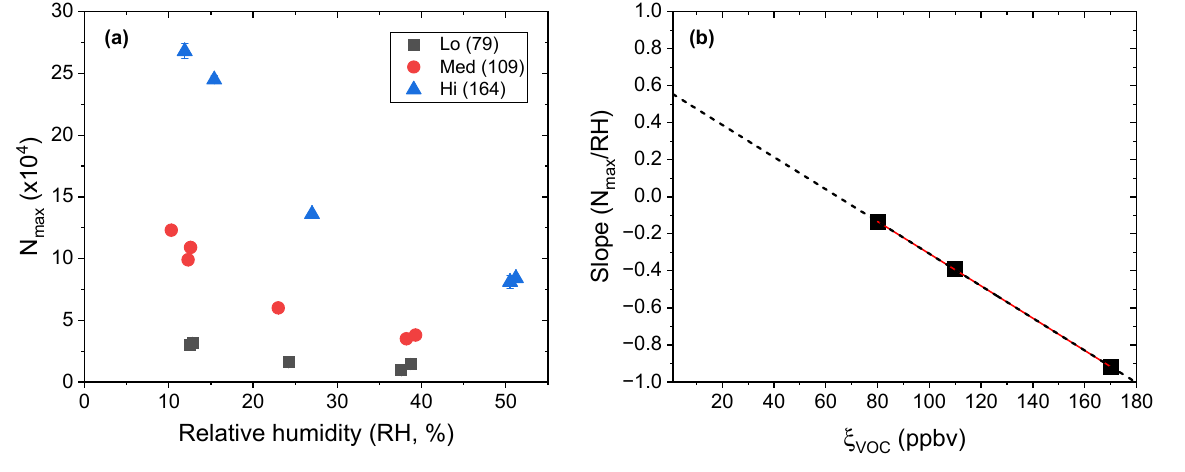
Figure 5. ( a ) Trends in NPF for β -pinene ozonolysis as a function of relative humidity. ( b ) Slope humidity trends in ( a ) as a function of ξ VOC . Here, N max data ( a ) were extrapolated from Emanuelsson et al. [11], and the slope at each ξ VOC ( b ) was determined by linear fits to the Emanuelsson data from 10 to 30% RH.